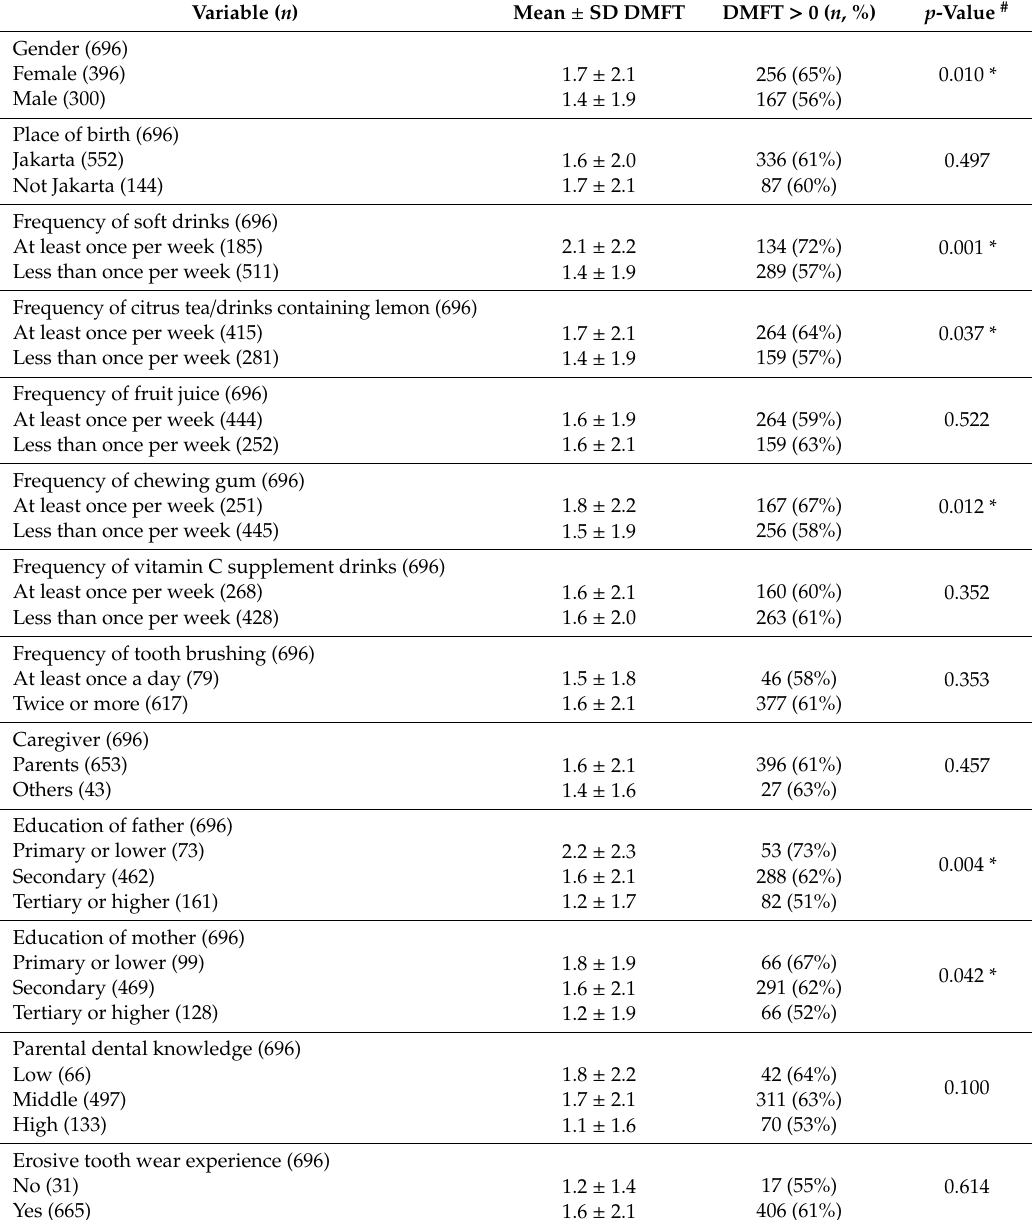
Table 2. Mean DMFT and caries prevalence according to selected